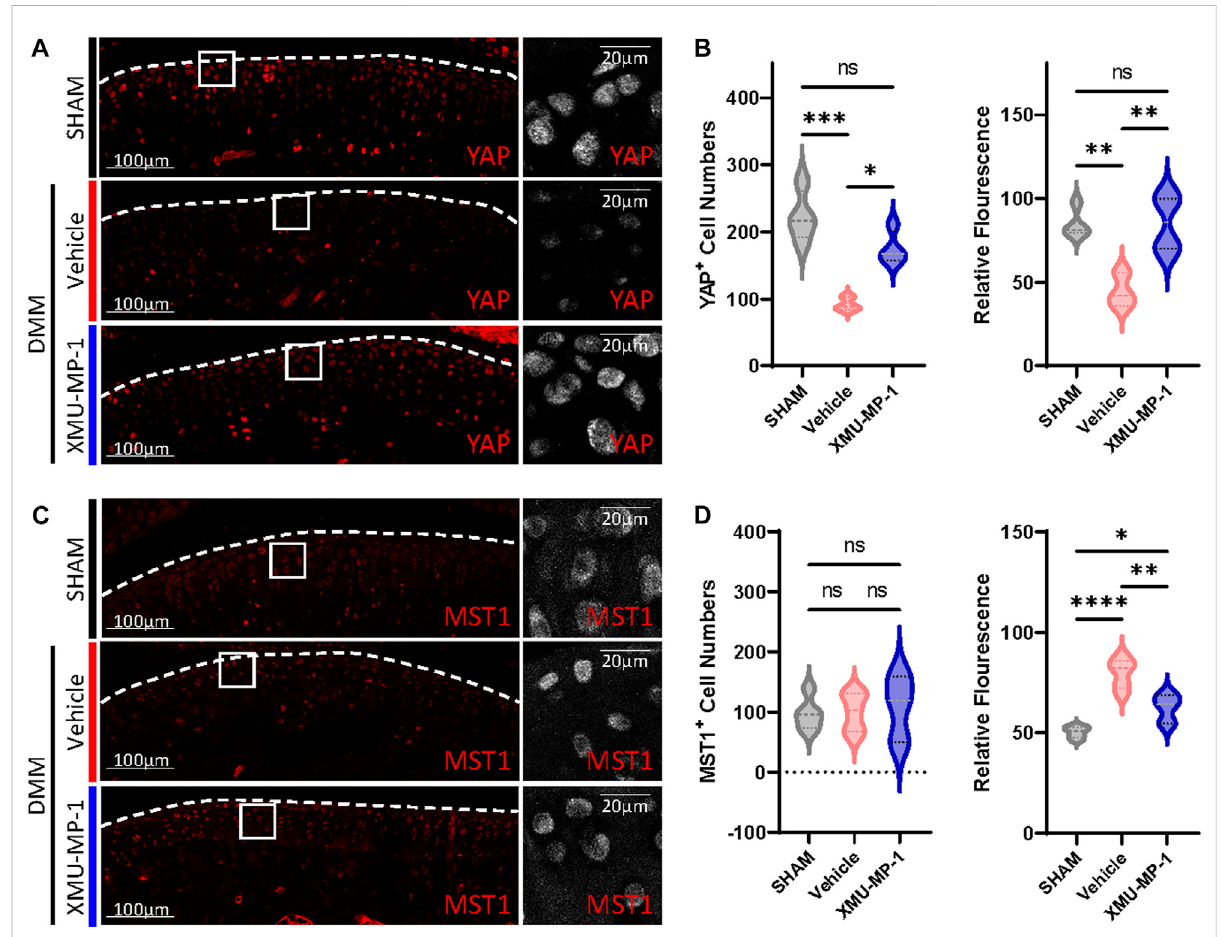
FIGURE 6 XMU-MP-1 attenuates OA pathogenesis via YAP. Representative images of knee joint sections of mice from indicated groups. SHAM: Mice underwent sham surgery. Vehicle: Mice undergoing DMM surgery were intraperitoneally injected with vehicle. XMU-MP-1: Mice undergoing DMM surgery were intraperitoneally injected with XMU-MP-1. Sections were immunostained with antibody against YAP (red or gray) (A) and MST1 (red or gray) (C) . (B) Statistical analysis of the YAP + chondrocytes numbers in articular cartilage in A. Panel on the left is quanti fi cation of YAP + chondrocytes numbers per cartilage. Panel on the right is the quanti fi cation of relative fl uorescence in YAP + chondrocytes. n = 4, 3, 4. (D) Statistical analysis of the MST1 + chondrocytes numbers in articular cartilage in C. Panel on the left is quanti fi cation of MST1 + chondrocytes numbers per cartilage.Panelontherightisthequanti fi cationofrelative fl uorescenceinMST1 + chondrocytes. n =5,5,3.Alldataarepresentedasmean±SEM.* p < 0.05, ** p < 0.01, *** p < 0.001, **** p <